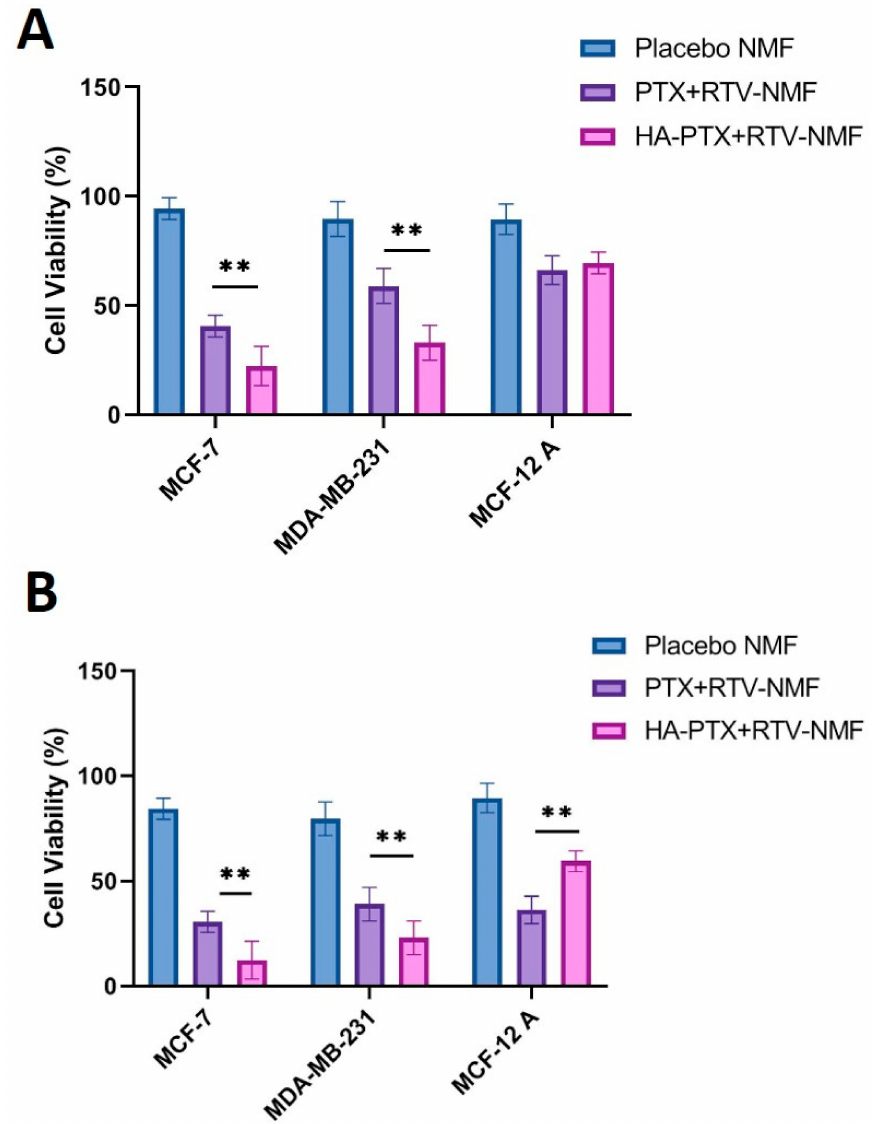
Figure 10. In vitro cell viability for nanomicellar formulations. ( A ) Cell viability (%) in MCF-7, MDA-MB-231, and MCF-12A cells treated with placebo NMF, PTX + RTV − NMF, and HA − PTX + RTV − NMF for 24 h. ( B ) Cell viability (%) in MCF-7, MDA-MB-231, and MCF-12A cells treated with placebo NMF, PTX + RTV − NMF, and HA − PTX + RTV − NMF for 72 h. The data were expressed as mean ± SD ( n = 3) (** p ≤ 0.01, ns = not significant as compared to PTX + RTV − NMF